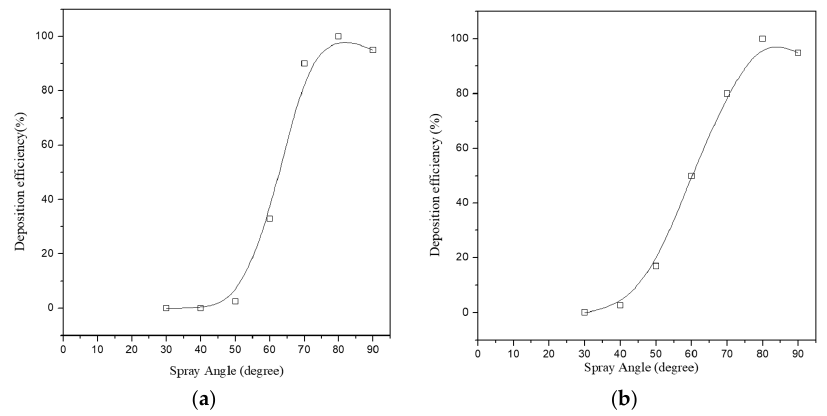
Figure 9. Effect of spray angle on deposition efficiency: ( a ) copper (15–37 μ m) and ( b ) titanium (37–44 μ m) [41].